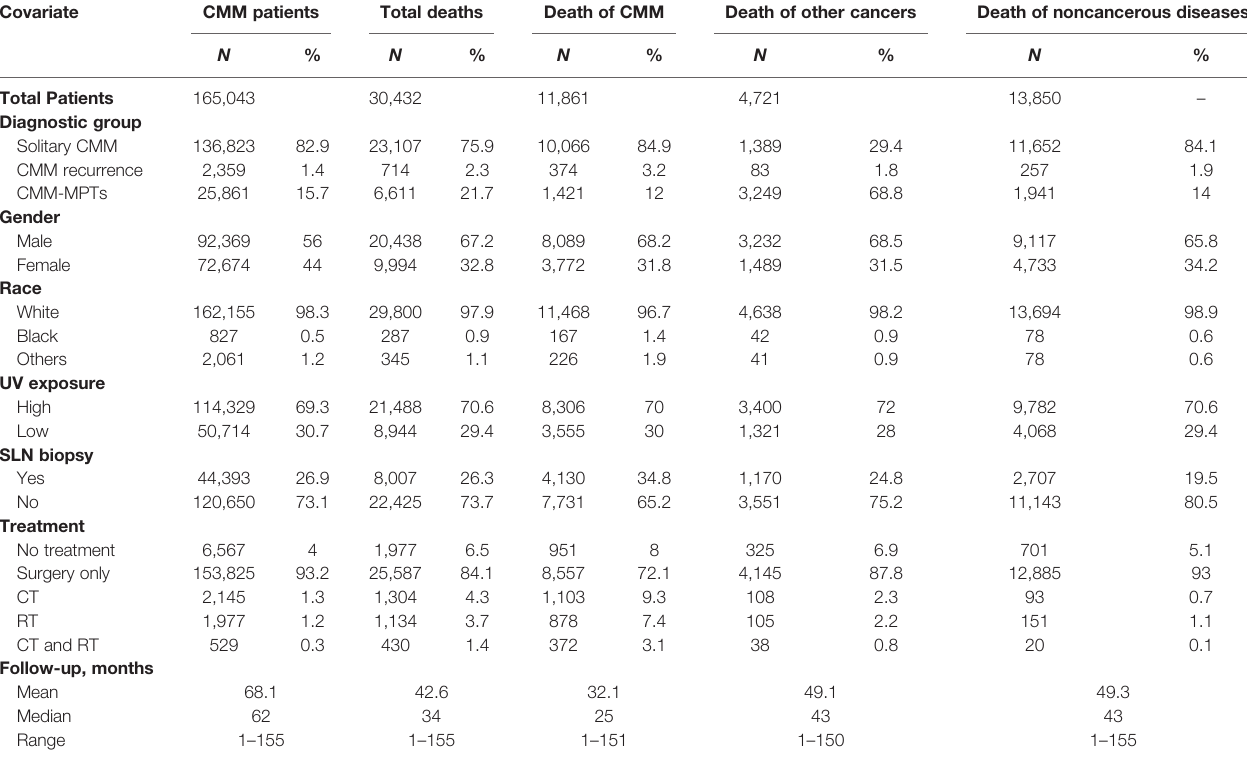
TABLE 1 | Demographics, clinical information, and incidence of cause-speci fi c death of CMM patients. Covariate CMM